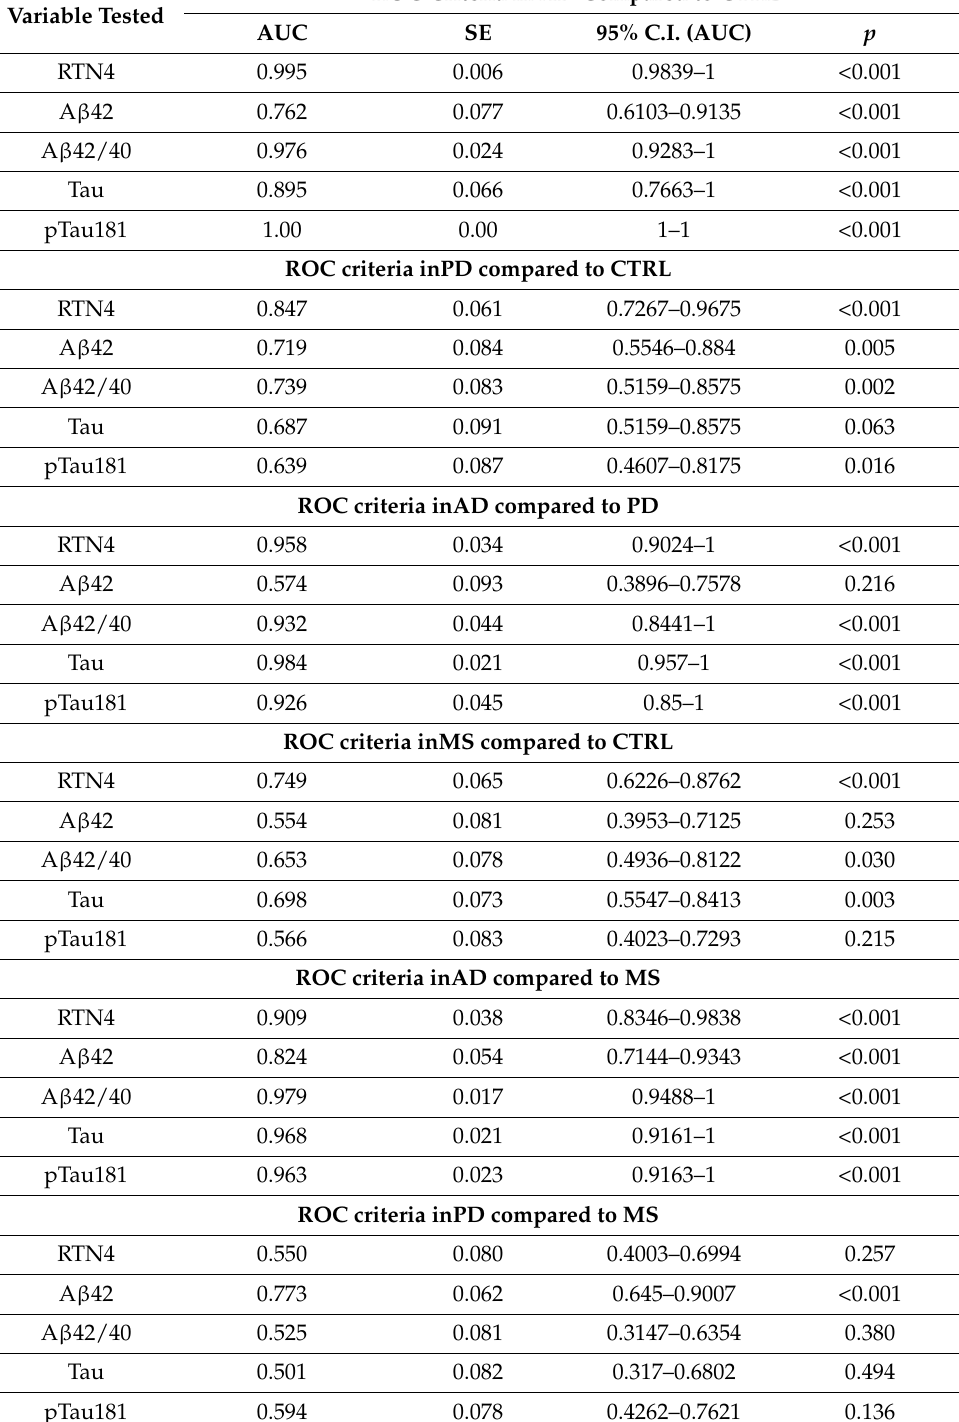
Table 2. AUC of tested proteins in compared